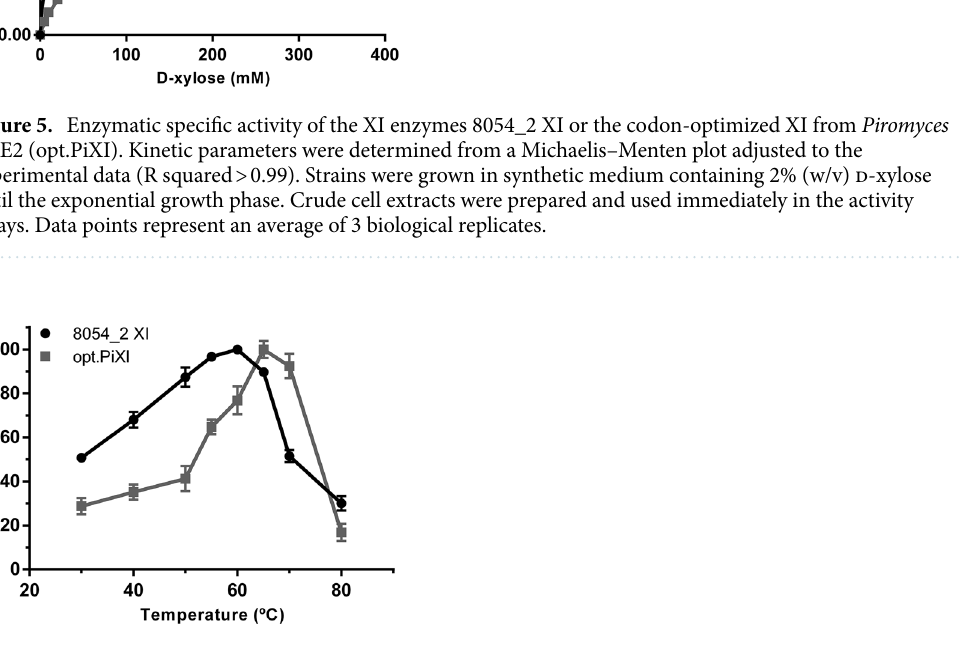
Figure 6. Relative enzymatic activity of XI enzymes 8054_2 XI and the codon-optimized XI from Piromyces sp. E2 (opt.PiXI) at different temperatures. Strains were grown in synthetic medium containing 2% (w/v) d-xylose until the exponential growth phase. Crude cell extracts were prepared and used immediately in the activity assays. Data points represent an average of 3 biological replicates with standard deviation